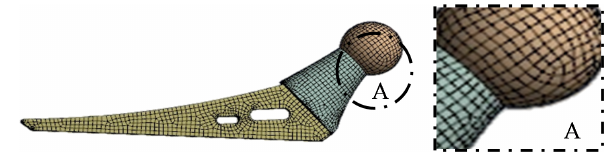
Figure 3: The shape of the FE model mesh used.